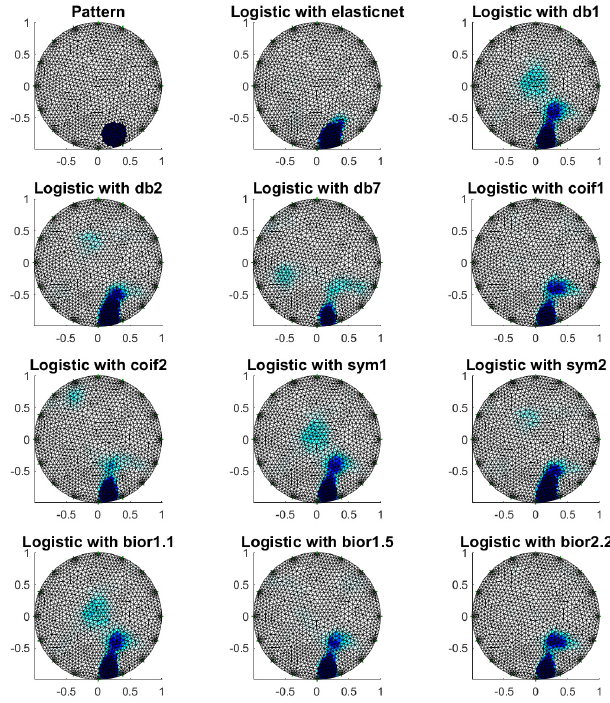
Figure 6. Image reconstruction for one object—example 1.